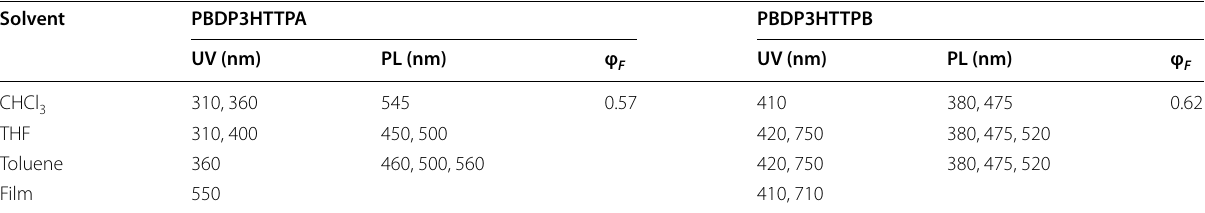
Table 2 UV–vis absorption and fluorescence emission maximum wavelengths, and the fluorescence quantum yields (φ of PBDP3HTTPA and PBDP3HTTPB